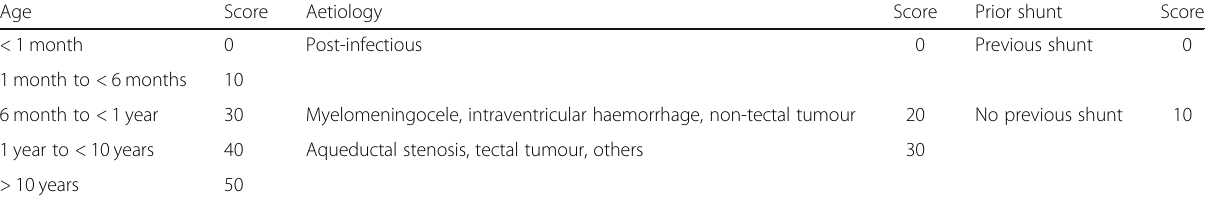
Table 1 Endoscopic third ventriculostomy success score (ETVSS)